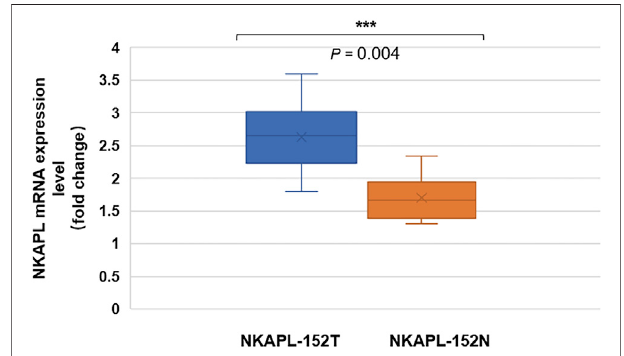
FIGURE 1 | Peripheral blood mRNA expression level of NKAPL-152N was decreased compared with that of NKAPL-152T carriers. The peripheral blood NKAPL mRNA expression level wasdecreased in152T carriers (n= 20) thanthatin152Ncarriers(n=20)inEOSpatients,byusingtheqRT-PCR